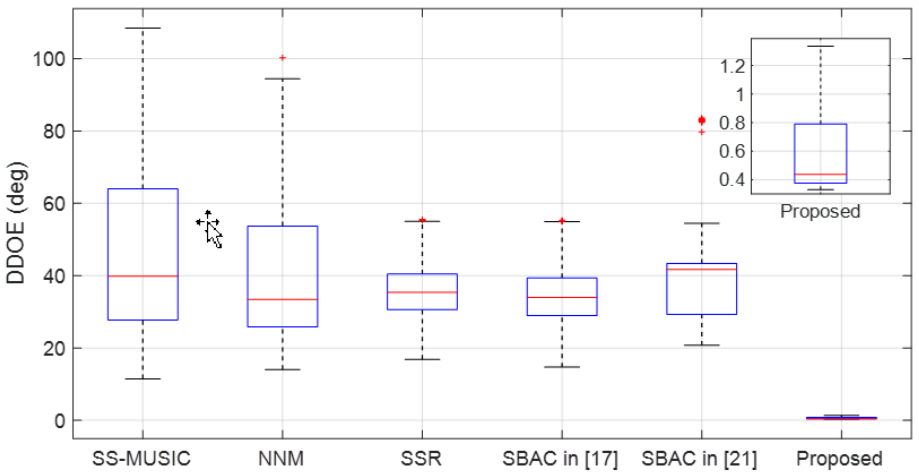
Figure 5. Box plots of DDOE for the tested algorithms.